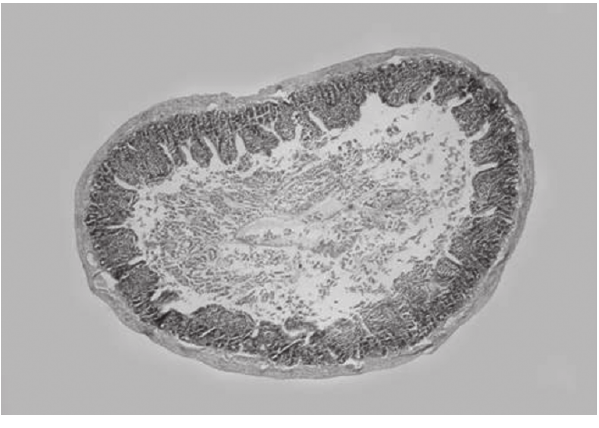
Figure 4 - Histological appearance of the L-NAME group. Epithelial separations and luminal epithelial seeding is obvious (H&E x